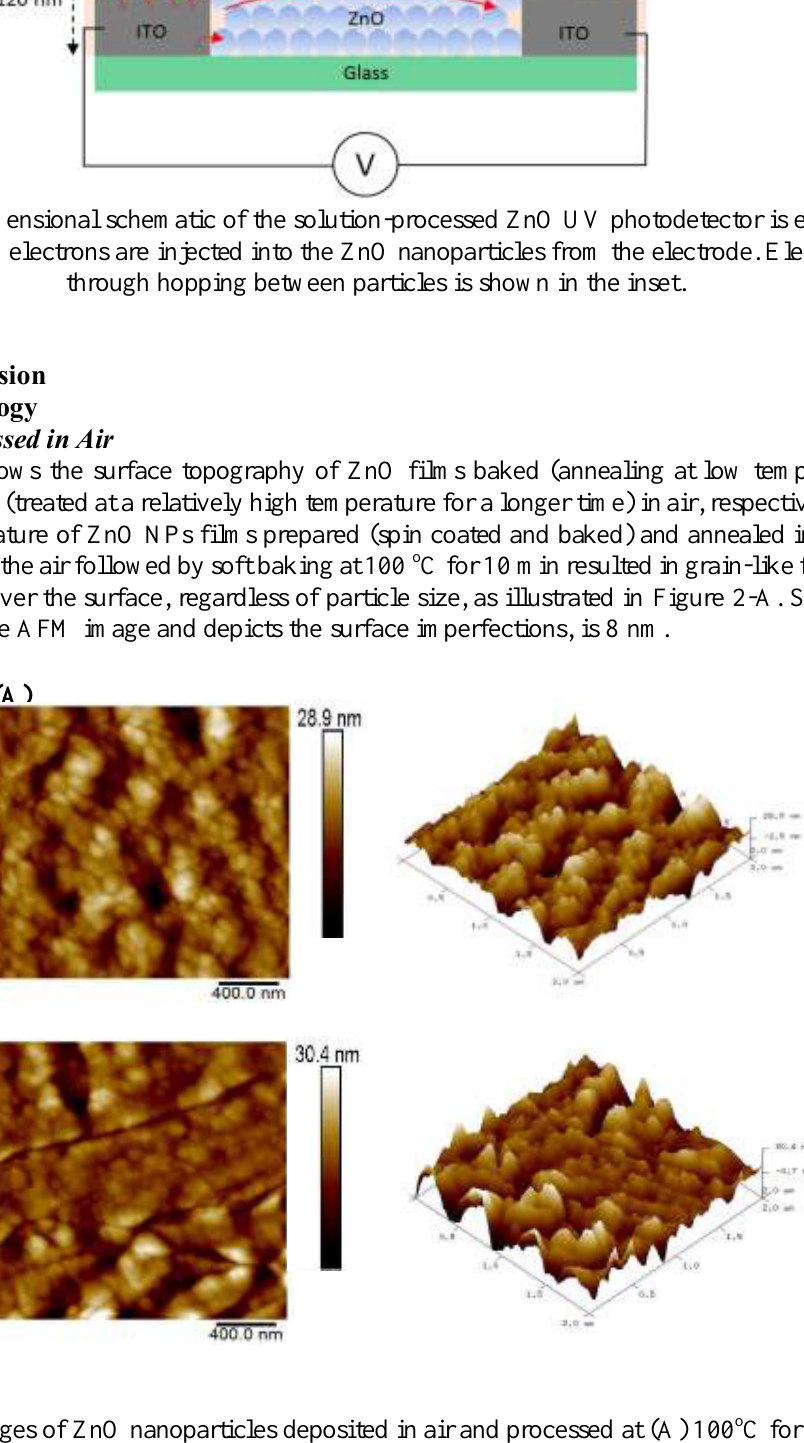
Figure 2: AFM images of ZnO nanoparticles deposited in air and processed at (A) 100 o C for 10 min and (B) 350 o C for 1h after baking. Surface roughness is calculated to be 8 nm for both